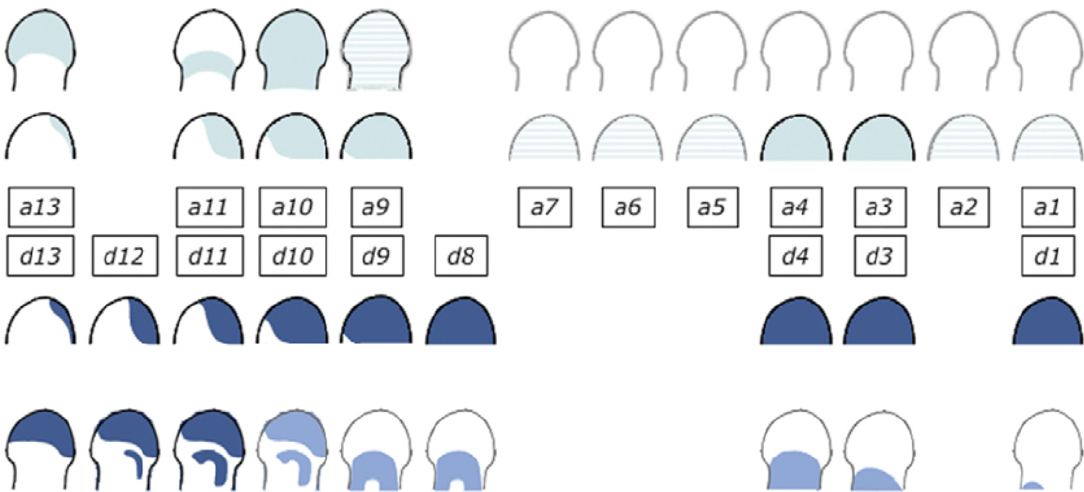
Figure 4. Hoxa and Hoxd expression in the developing limb. Two phases of expression of Hoxa and Hoxd genes. During phase 1, genes are activated sequentially in both clusters, following the same general collinear strategy, with ‘posterior’ genes (e.g., group 13) transcribed in progressively more posterior cells of the limb buds. During the second (late) phase, Hoxa and Hoxd patterns are still quite comparable, but with obvious differences, suggesting that different regulations are now implemented. Reprinted from Elsevier, in keeping with the guidelines from the STM permissions association, from the source: Zakany J, Duboule D. The role of Hox genes during vertebrate limb development. Curr Opin Genet Dev. 2007;17(4):359–366 [15].